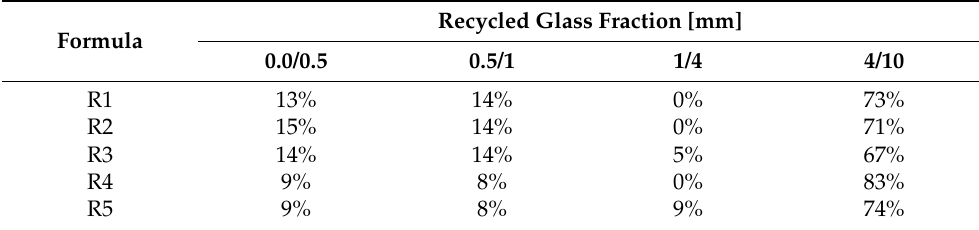
Table 3. Percentage of the individual fractions of glass in recipes R1 to